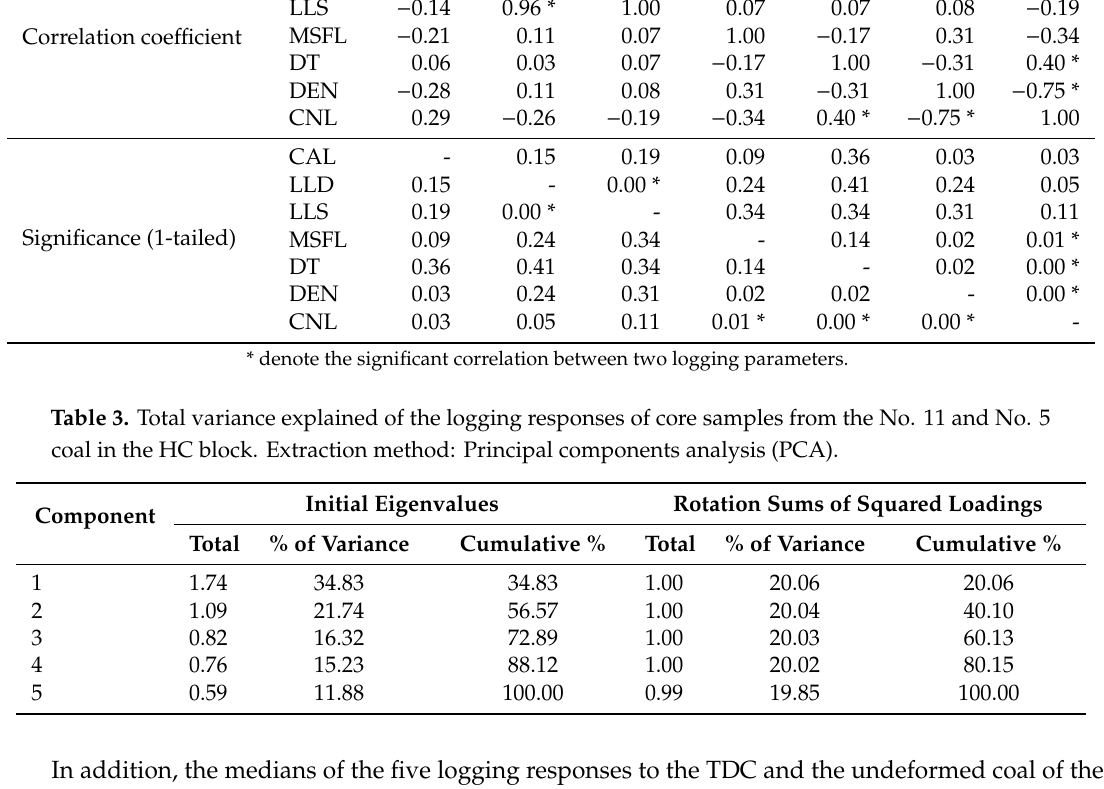
Correlation coe ffi cient